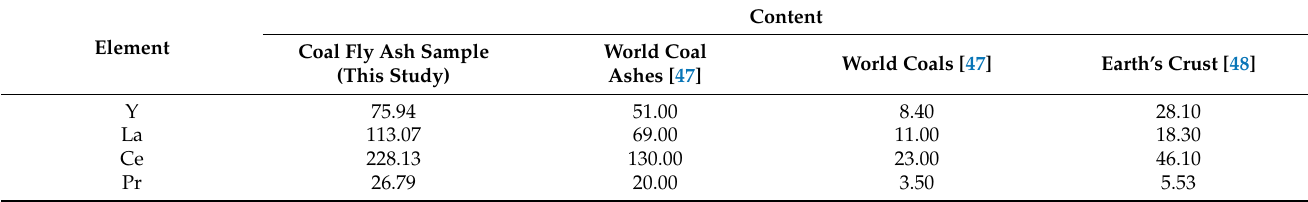
Table 4. Contents of the rare earth elements in coal fly ash from the Qianxi power plant in Guizhou compared with other samples